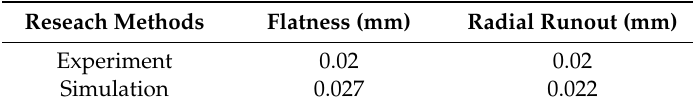
Table 7. Deformation in the experiment and the